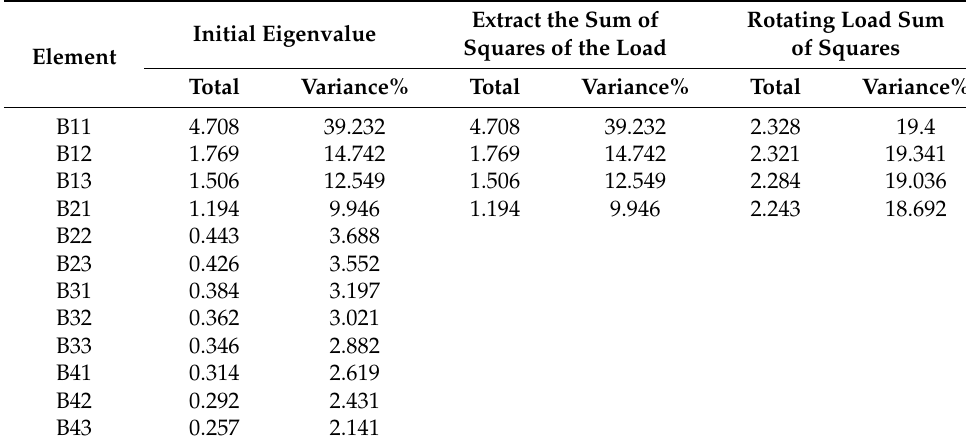
Table A3. Psychological Empowerment Total Variance